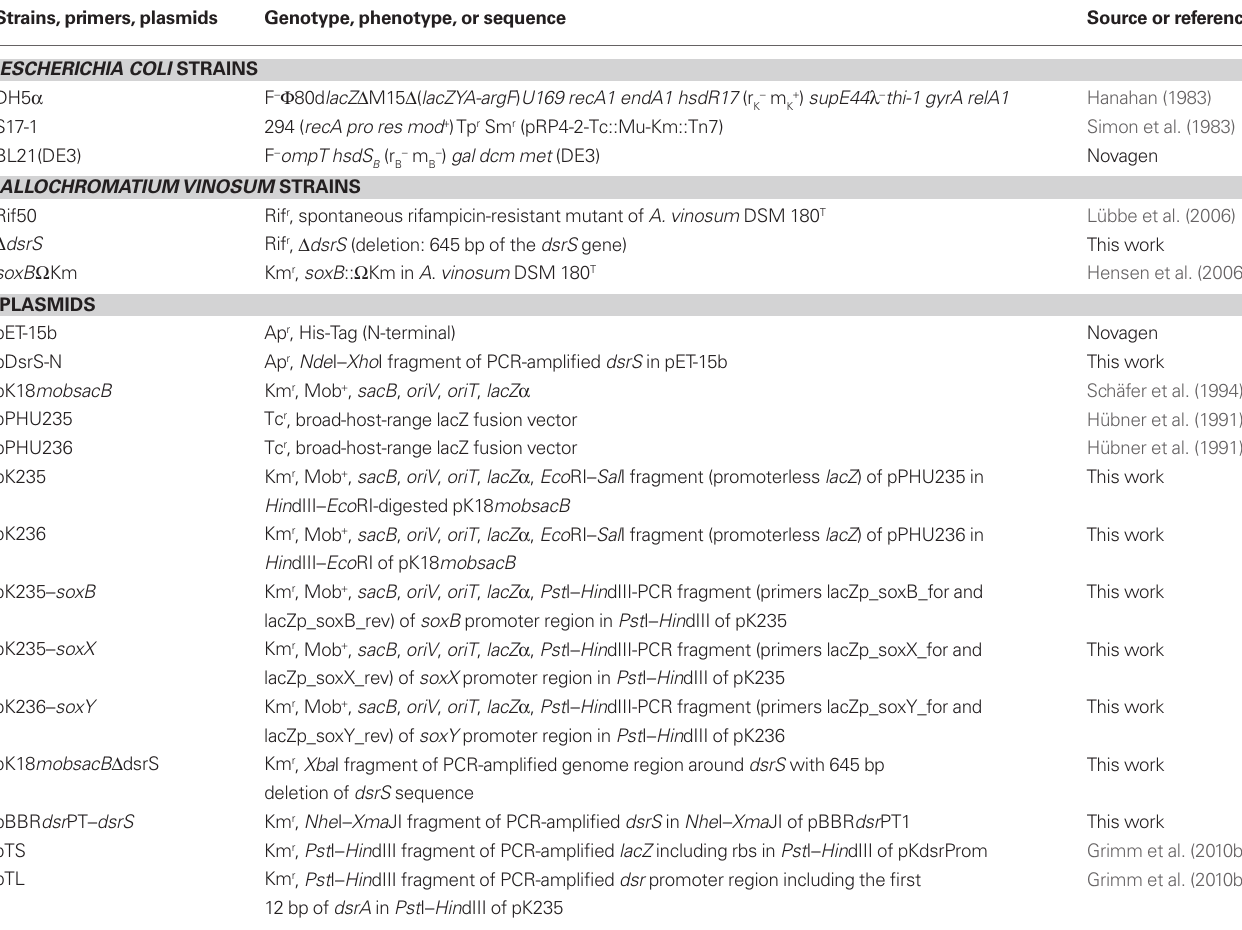
Table 1 | Bacterial strains and plasmids. Strains, primers, plasmids Genotype, phenotype, or